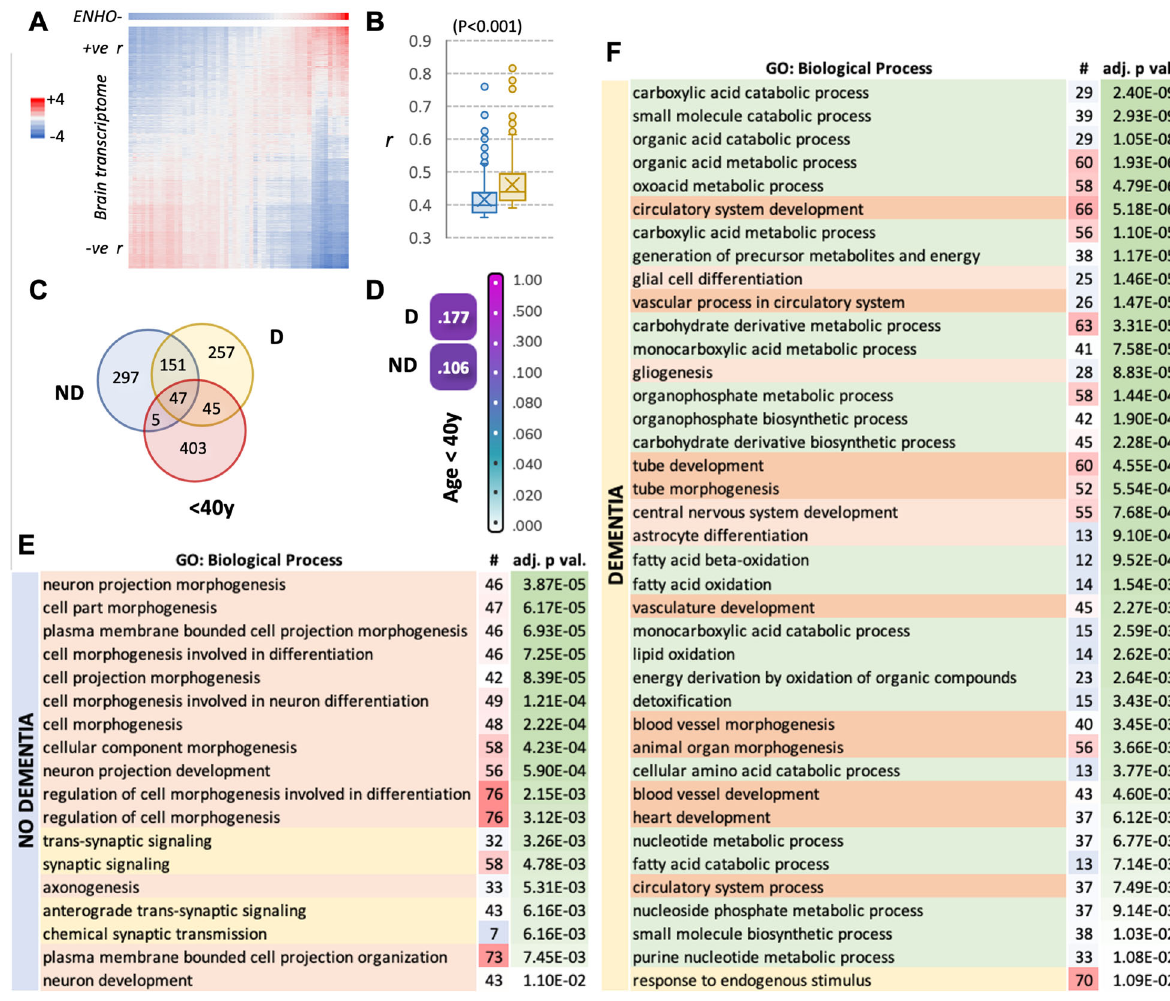
Fig. 2 Correlations between ENHO and gene networks differs between dementia state of the old-old. A Correlation matrix heat map showing the relationships between z -scores for ENHO expression and the brain transcriptome. The matrix is representative and was derived from The Atlas of the Developing Human Brain. Genes with a mean expression level (RPKM) of >10 were selected; each pixel is a bin comprised of the averages of ten samples, with ten genes in each sample. B Correlation coef fi cients (r) between expression of ENHO and the top 1% of genes. ENHO expression shows a tighter correlation, indicated by higher r, in brain samples isolated from the old-old who diet with a dementia diagnosis ( ‘ D ’ ) compared to the old-old without a dementia diagnosis ( ‘ ND ’ ). C Venn diagram showing overlap in the top 500 genes correlating with ENHO expression (ranked by correlation coef fi cient) for the ND group, D group and people aged < 40 years (< 40 y). D Comparison of biological processes correlating with ENHO expression in the ND group, D group and people aged < 40 years. A score > 0.1 indicates a signi fi cant correlation between groups; the D and < 40 y groups appear to be more closely related. E , F GO:Biological Processes correlating with ENHO expression in ND group ( D ) or D groups ( E ). ‘ # ’ refers to the number of hits (genes); processes with an adjusted p value of < 0.01 are shown. Biological processes are color coded (orange for neural development, green for metabolism, yellow for